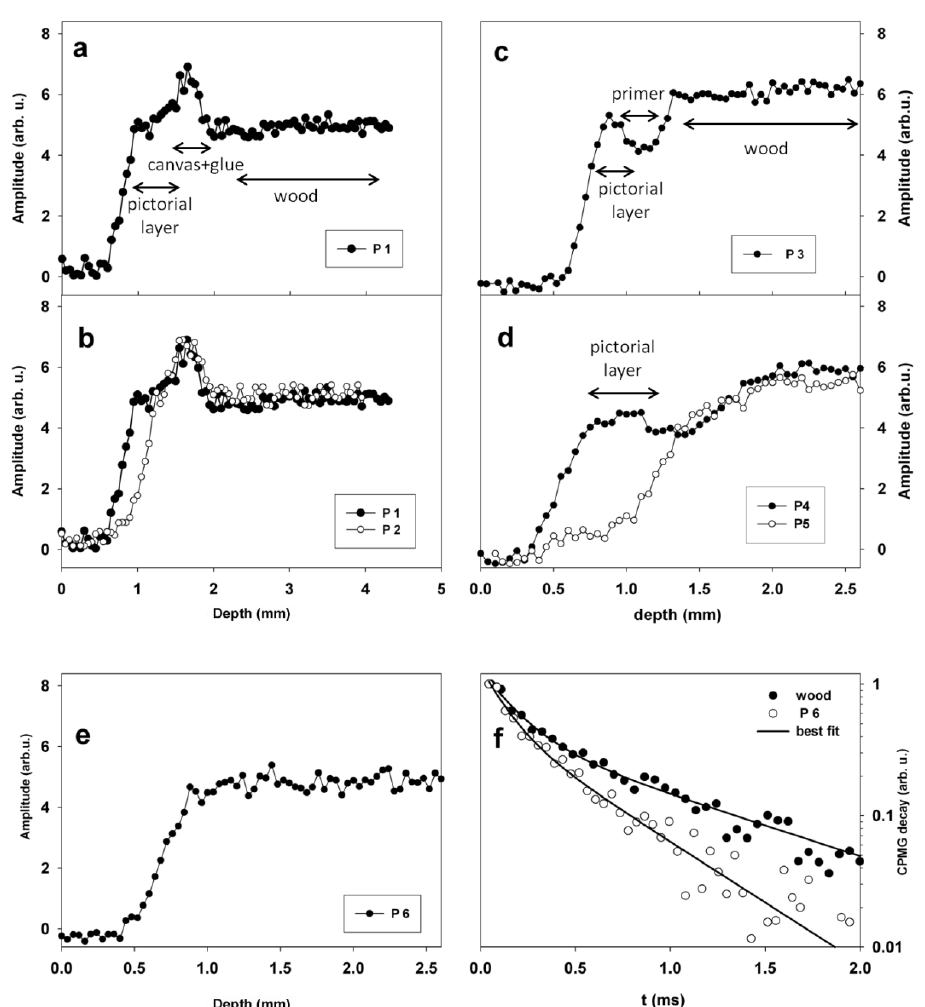
Figure 6. ( a–e ) NMR stratigraphies measured in different regions of the icon; ( f ) Comparison between CPMG decays measured on region P6 at a depth of 1 mm, and on the same region at a depth of 2.5 mm on